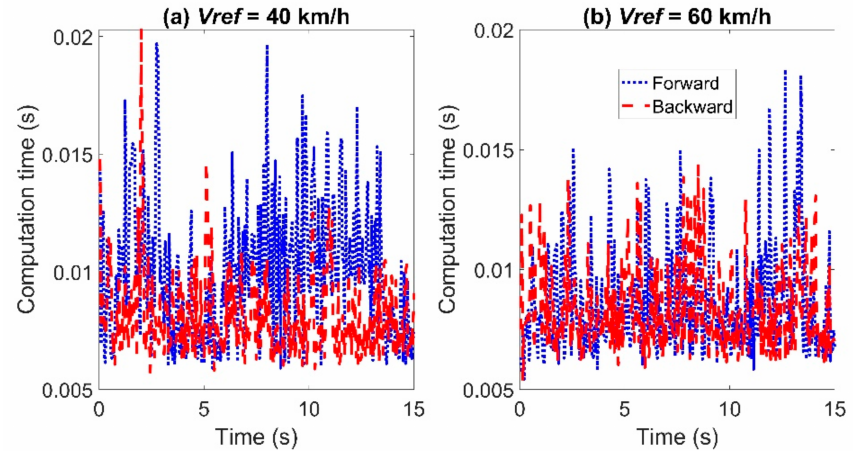
Figure 5. Comparison of the computation time for tracking the sinusoidal trajectory with T s = 0.05 s: left for Case ( a ) with Vref = 40 km/h and right for Case ( b ) with Vref = 60